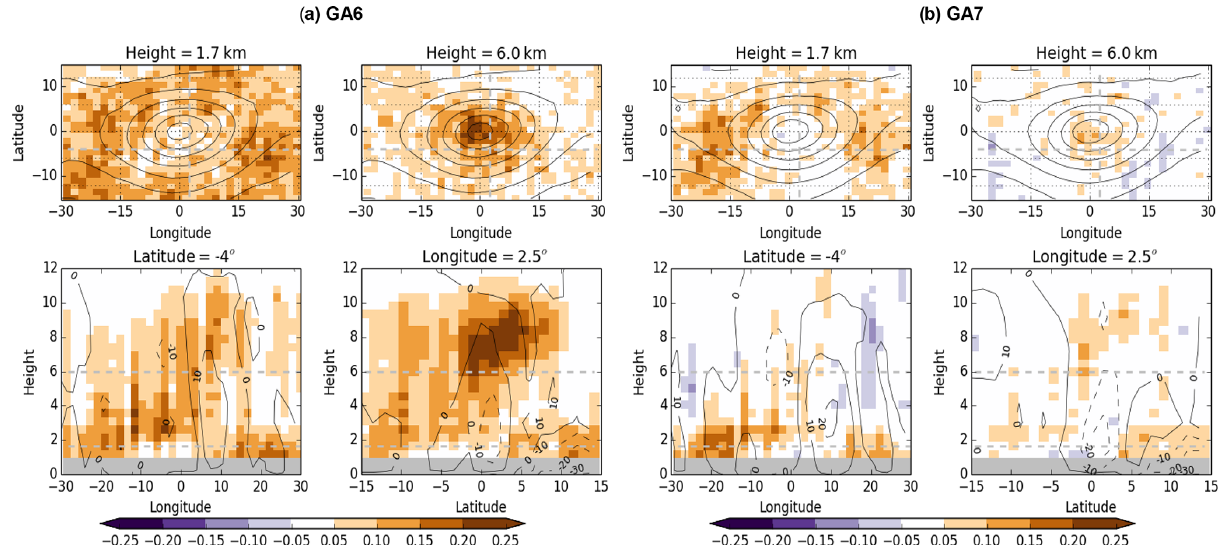
Figure 7. Cloud fraction absolute bias (model field minus observed field; colours) for composite cyclones. Produced as per Fig. 6 for (a) GA6 and (b) GA7, with the observed composite then subtracted. Black contours in top plots are the model mean PMSL and in the lower plots are the bias in vertical velocity. Student’s t -test based on inter-annual variability shows that errors greater than 0.05 are statistically significant at the 0.05